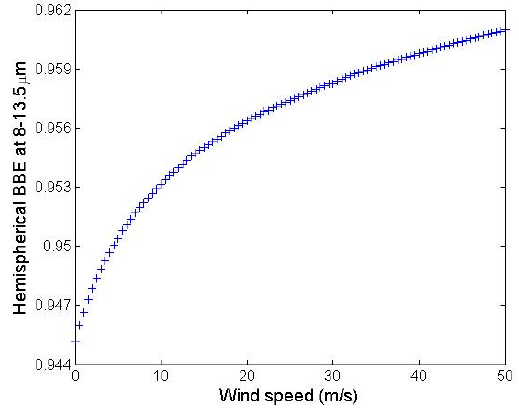
Figure 8. Scatterplot of hemispherical BBE with respect to wind speed.